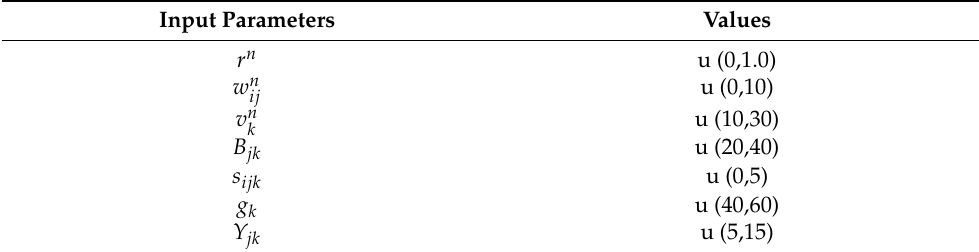
Table 2. Input parameters for the change in the number of yard blocks and time windows.